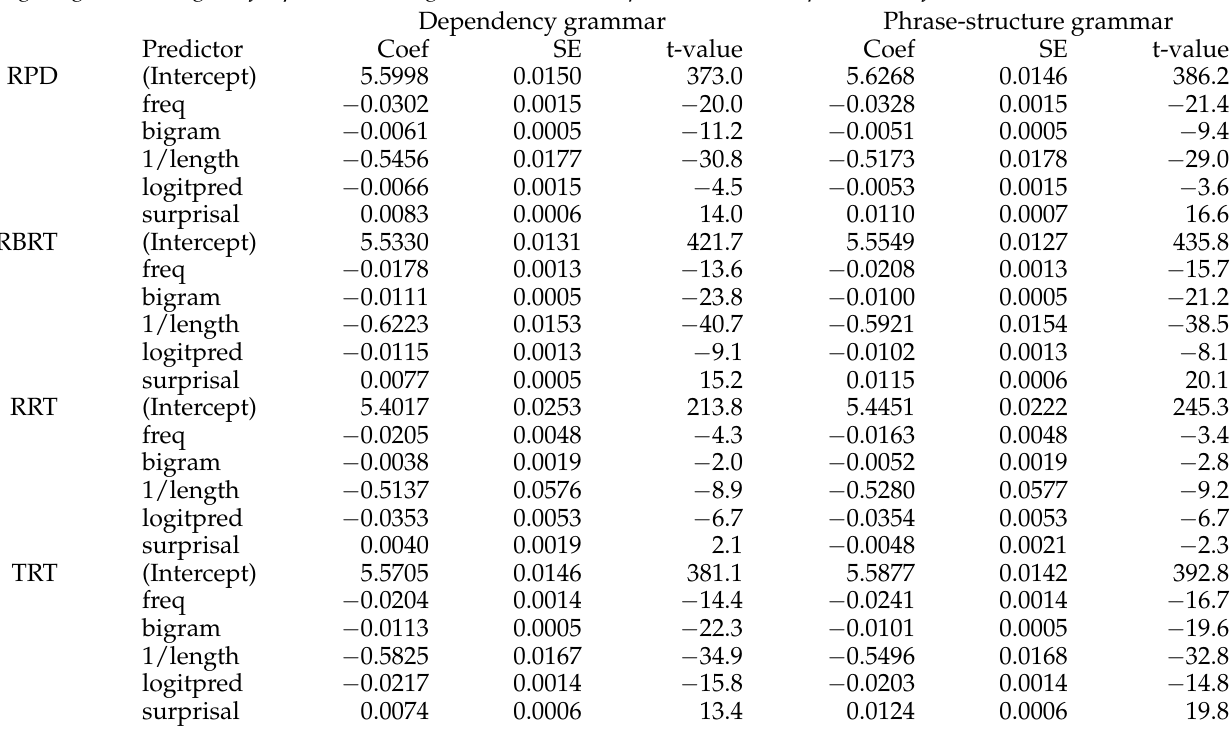
Log unigram and bigram frequencies, 1/length, and the two surprisal variants as predictors of the so-called late measures. Dependency grammar Phrase-structure grammar